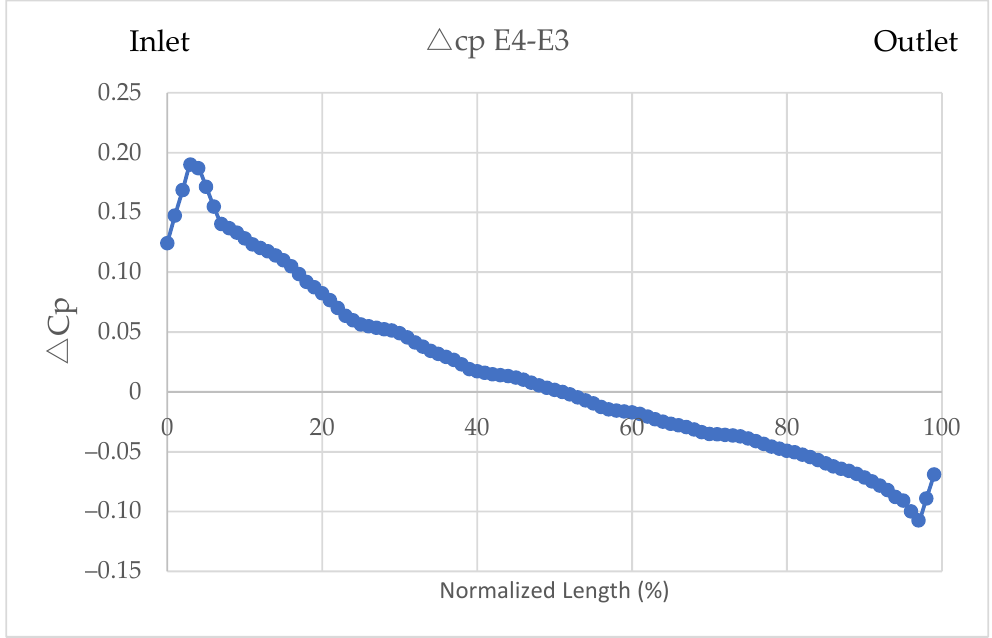
Figure 19. Coefficient of the pressure difference between E4-E3.